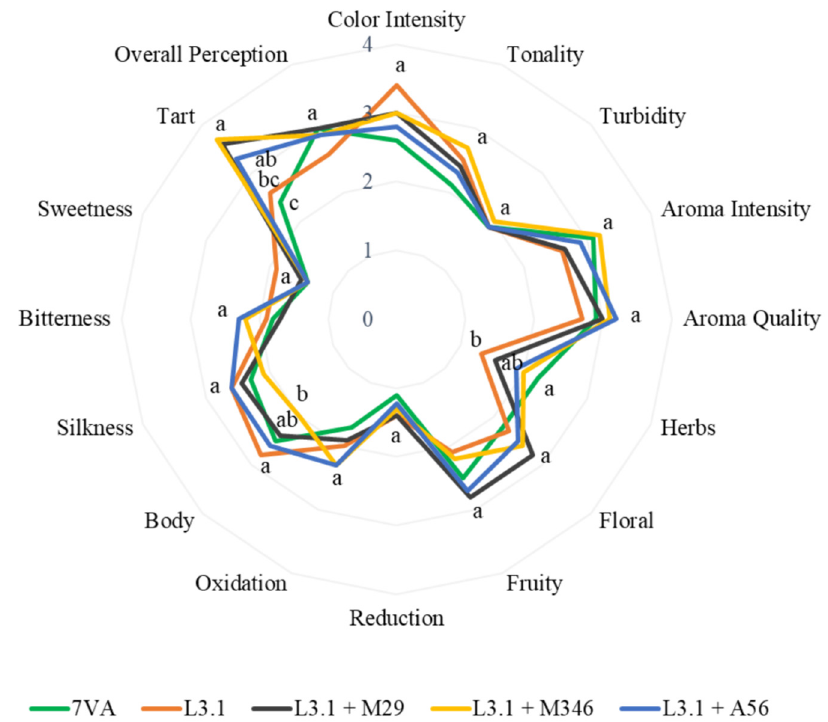
Figure 5. Two-dimensional radar chart for wine-tasting descriptors. Different letters indicate signif- icant difference between means ( p < 0.05).